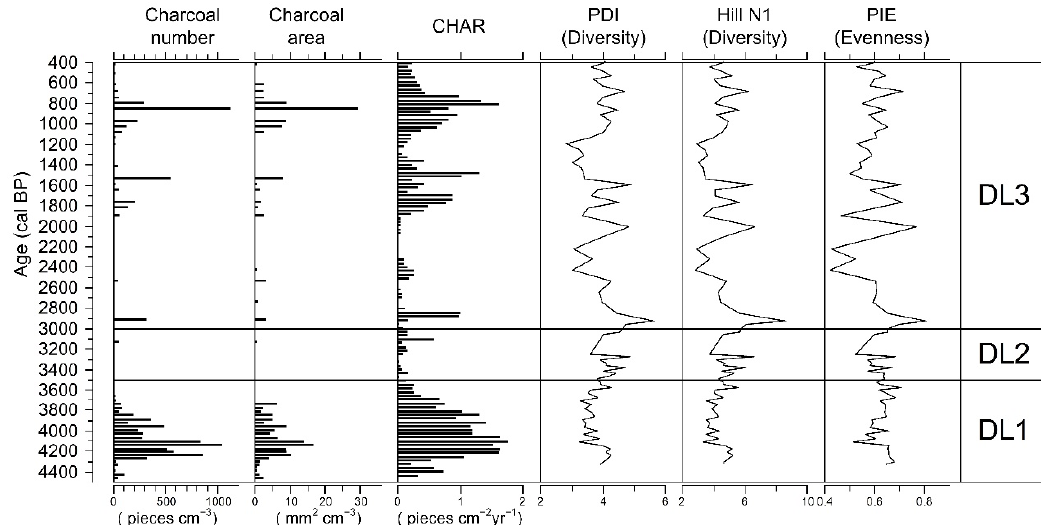
Figure 6. Profile of charcoal concentration (number and area of pieces), charcoal accumulation rate (CHAR), pollen-type diversity (PDI), Hill’s number (Hill N1), and probability of interspecific encounter (PIE) with respect to the three pollen zones in the Dream Lake sediment core. DL4 was considered to represent modern deposition and was excluded from the diagram.